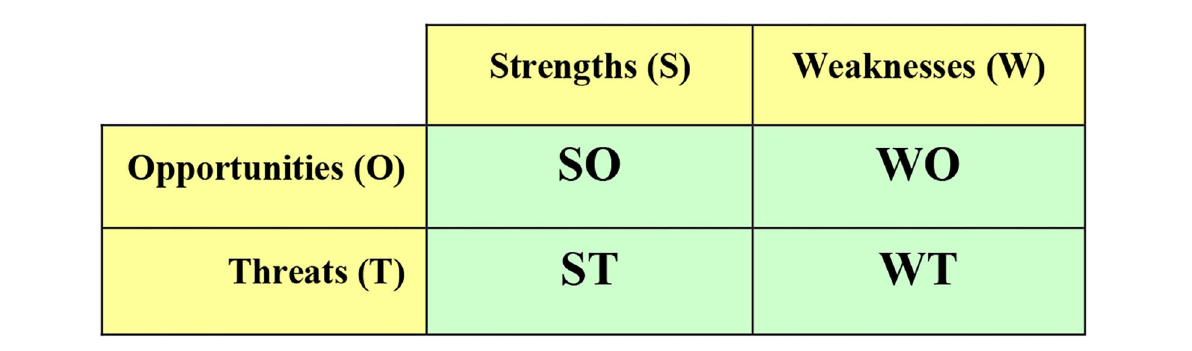
a Farmers:Measuringisdonebasedonthespectrumfromnobody(0)toalloffarmers(20). b Experts:Measuringisdonebasedonthespectrumfromnobody(0)toallofexperts(10).